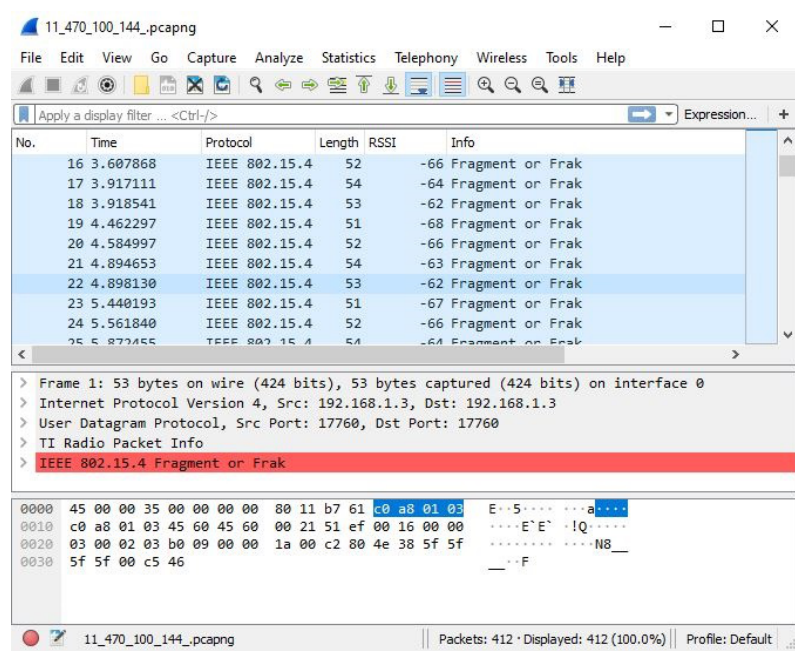
Figure 5. Wireshark